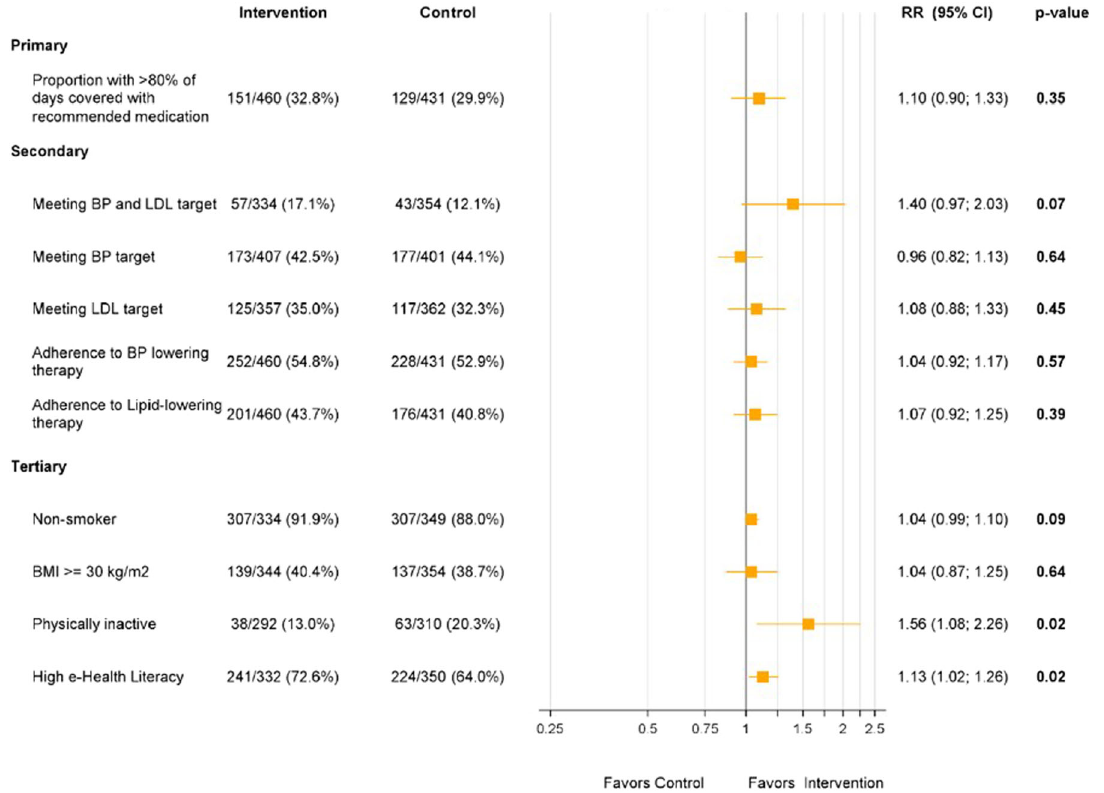
Fig. 3 Trial outcomes. CI con fi dence interval, RR relative risk, BP blood pressure, LDL low-density lipoprotein cholesterol, BMI body mass index, kg kilogram, m